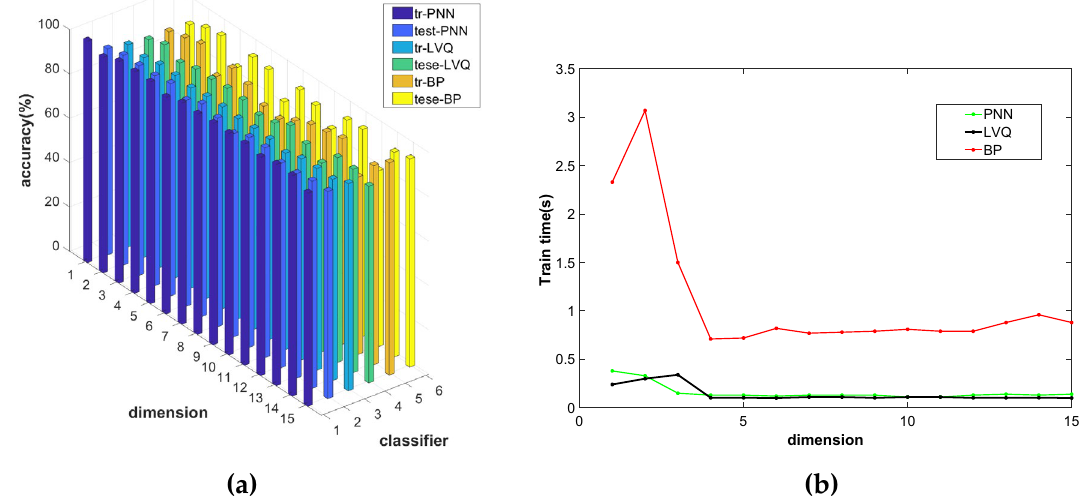
Figure 4. Comparison diagram of NRS-PNN, NRS-LVQ and NRS-BP models: ( a ) Accuracy comparison chart; ( b ) Comparison diagram of test time.